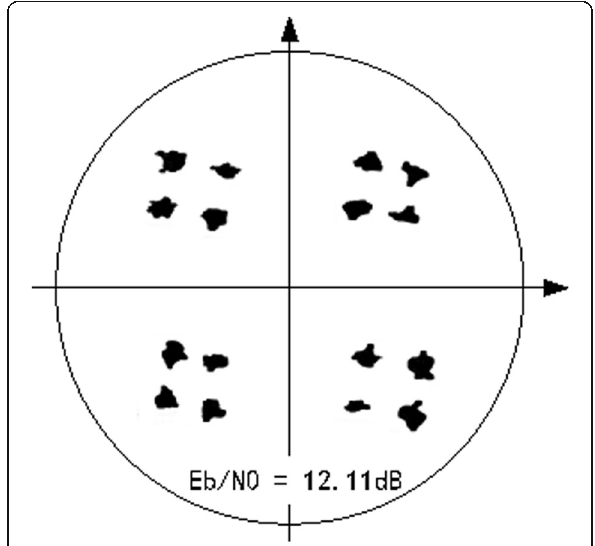
Fig. 11 After filtering (15 dB polarization interference). This figure shows a constellation graph after filtering (15